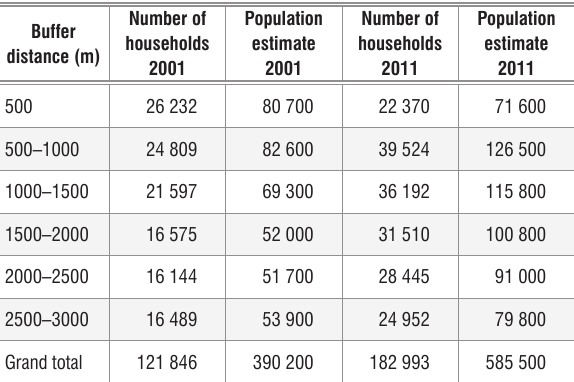
Households and residential areas around tailings storage facilities during 2001 and 2011 with estimates of population for